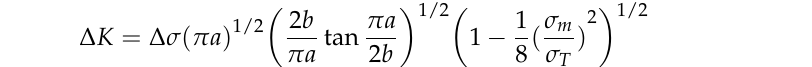
value of ( dNd / α ) decreases successively, and approaches to zero. When ( dNd / α ) = timately leads to the failure of the part.